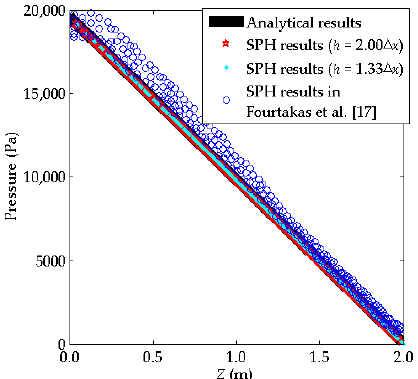
Figure 8. Comparison of the hydrostatic pressure of all fluid particles with the analytical results.